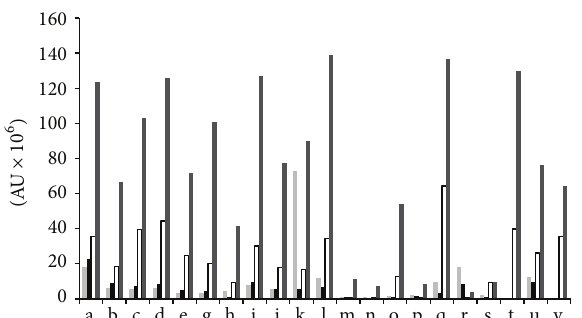
Figure 1: Area units (AU) of chromatographic area of each free amino acid detected in fresh loin and dry-cured ham samples by using stomacher (light grey and white, resp.) and mixer mill (black and dark grey, resp.) as homogenization tools. Alanine (a), glycine (b), valine (c), leucine (d), isoleucine (e), proline (g), methionine (h), serine (i), threonine (j), phenylalanine (k), aspartic acid (l), hydroxyproline (m), cystine (n), glutamic acid (o), asparagine (p), lysine (q), glutamine (r), arginine (s), histidine (t), tyrosine (u), and tryptophan (v).